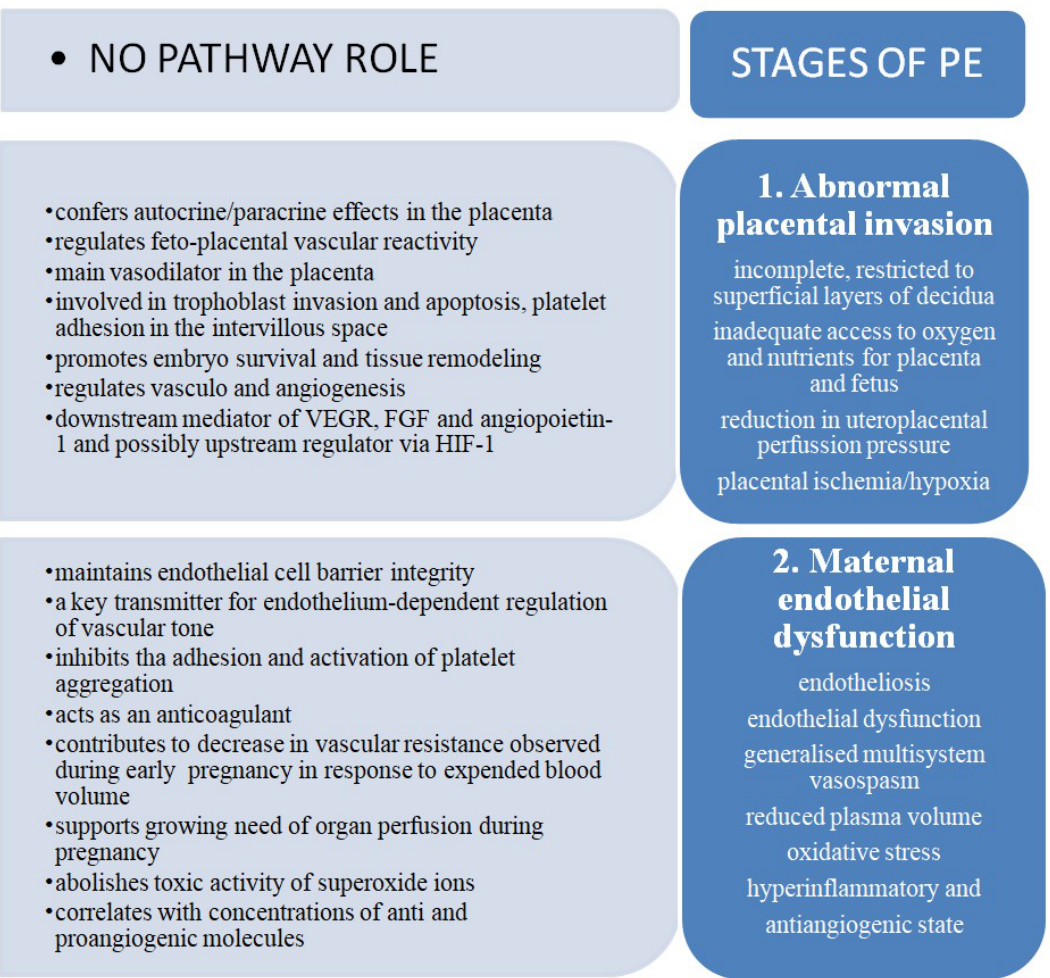
Figure 1. Physiological roles of NO pathway in pregnancy and their possible influence on preeclampsia (PE) development in two-stage model of disease. NO PATHWAY ROLE: Nitric oxide (NO) pathway role; STAGES OF PE: Stages of preeclampsia (PE).